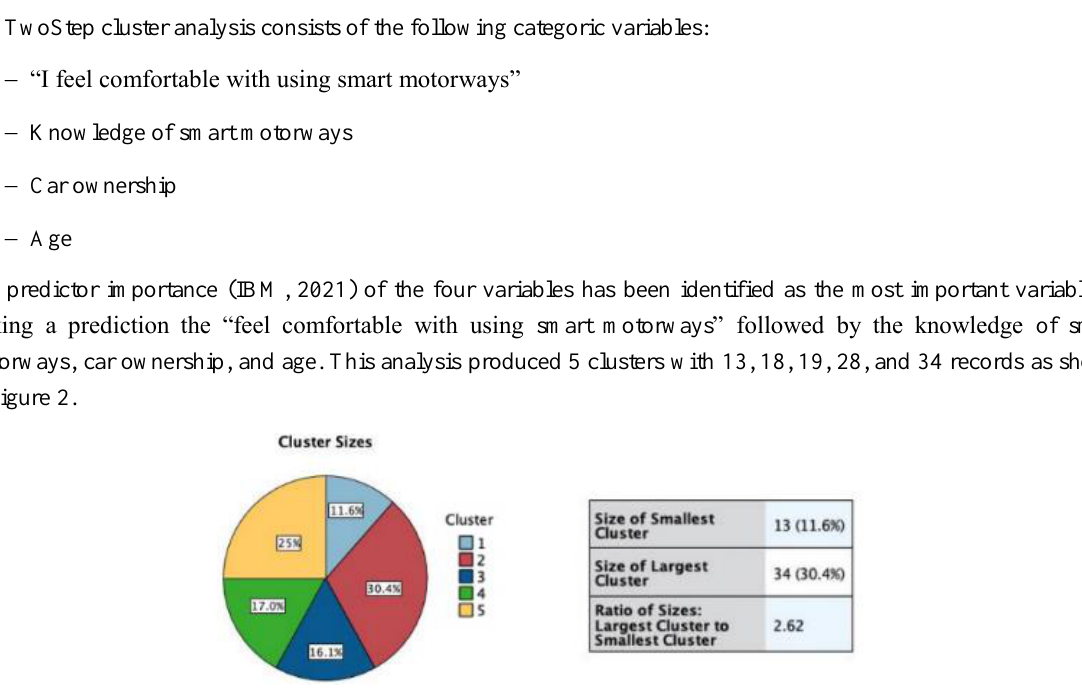
Figure 2 Clusters of cluster analysis